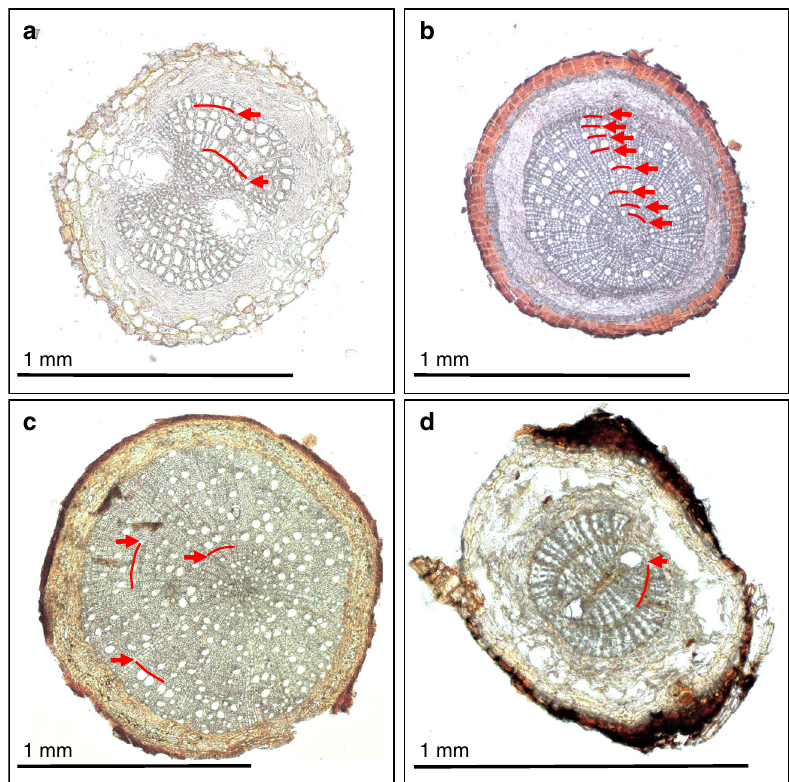
Fig. 1 Examples of annual growth rings in the secondary xylem of fi ne roots. a Pinus sylvestris (pine), b Betula nana (birch), c Fagus sylvatica (beech) and d Picea abies (spruce). Red arrows denote transitions from latewood of the previous to earlywood of the following growing season. The black line represents the length of 1 mm. The ring boundaries of beech are more dif fi cult to recognize as compared to the other studied species as they can be